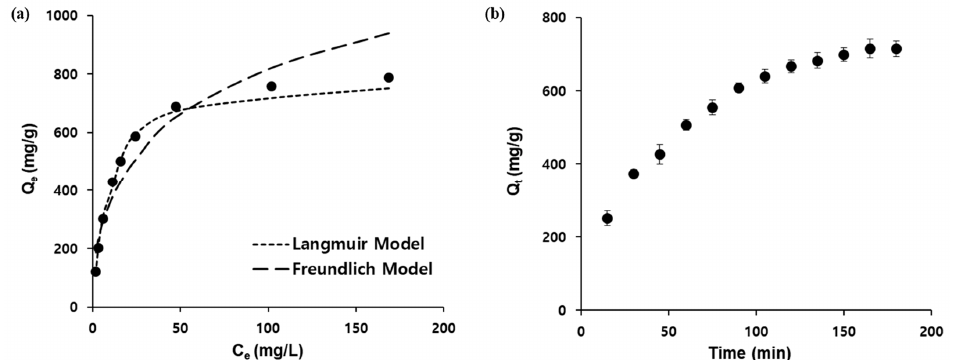
Figure 4. ( a ) UV absorption spectra of iodine after treatment with Fe 3 O 4 or Ag/Fe 3 O 4 composite nanoparticles in water; ( b ) removal efficiency of Ag/Fe 3 O 4 nanocomposites at high salt concentrations, and the control study using Fe 3 O 4 nanoparti- cles.